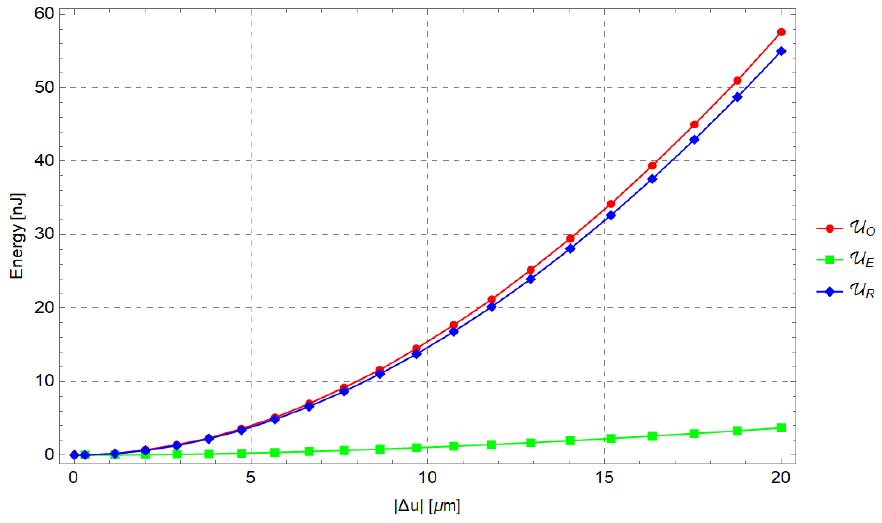
Figure 21. U O , U R , U E as a function of input displacement | ∆ u | , due to the input force F m